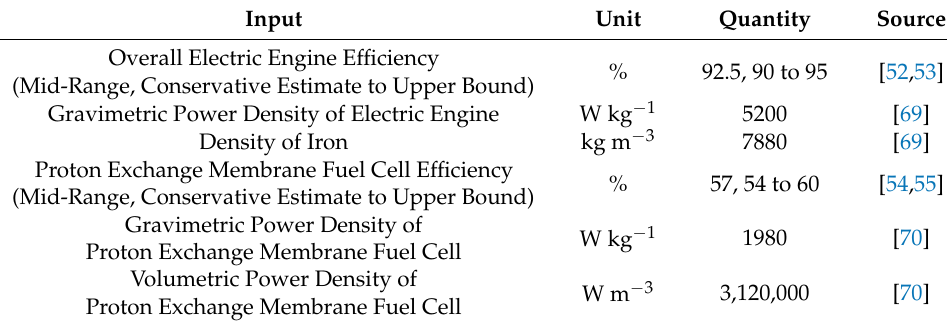
Table 8. Electric propulsion component data [52–55,69,70].